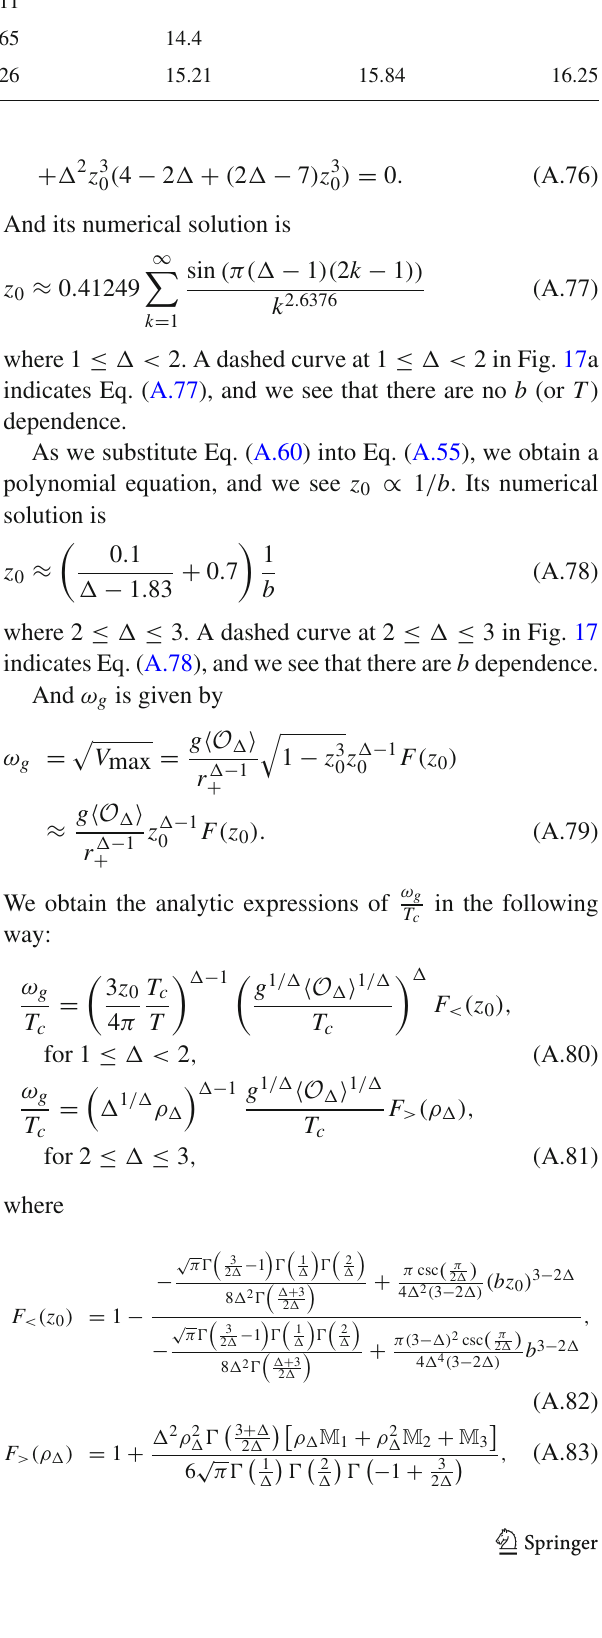
Table 4 ω n and T at lower T ’s. where n = 1 , 2 , 3 ,... . A position of the pole is obtained from Eq. (A.75) with given T T c T c program Poles of σ(ω) ω 1 T = 0 . 1 with ω / T = 10 . 9 g c T c